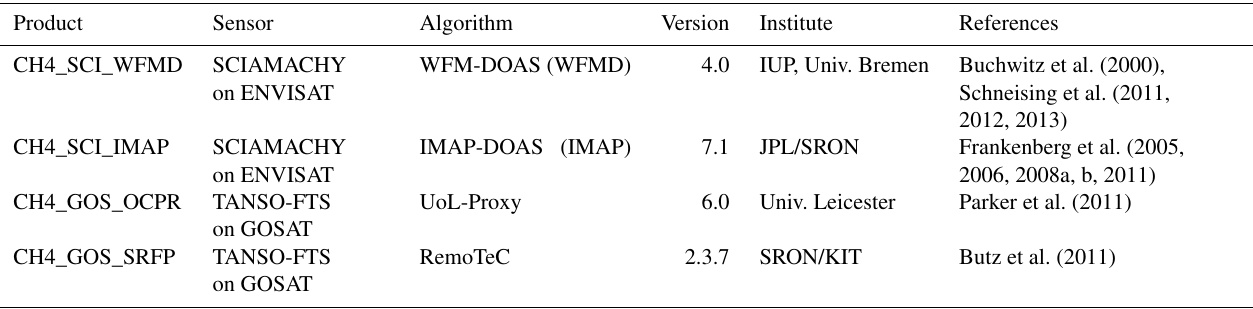
Table 1. Overview of the satellite X CH 4 data products used.